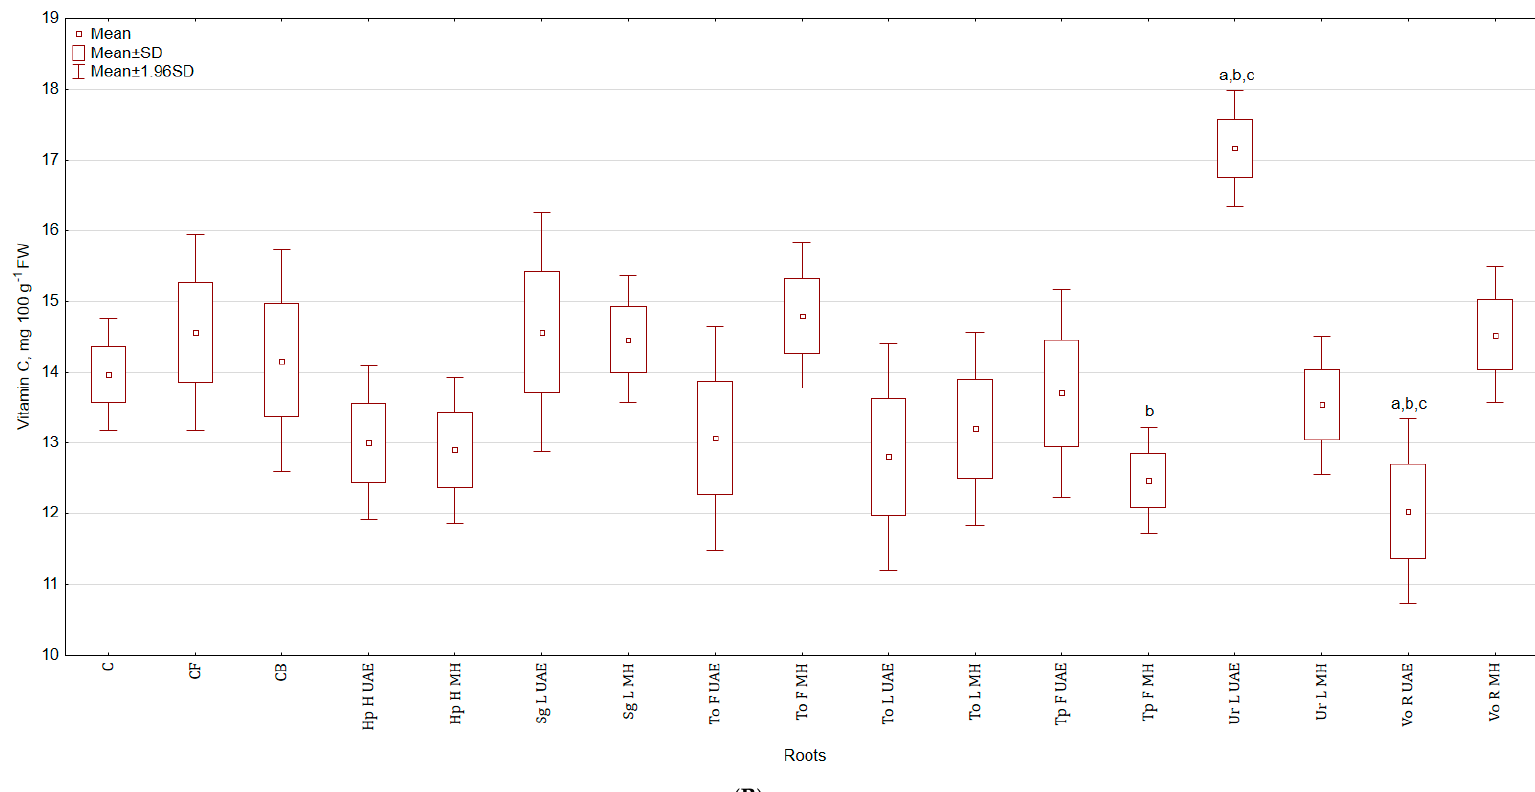
Figure 3. ( A ) Effect of the foliar application of botanical extracts on the vitamin C content of celeriac leaves (N = 4). ( B ) Effect of the foliar application of botanical extracts on the vitamin C content of celeriac roots (N = 4). (a) Statistically significant differences ( p < 0.05) between the control group (C) and extracts. (b) Statistically significant differences ( p < 0.05) between water formulation (CF) and extracts. (c) Statistically significant differences ( p < 0.05) between commercial biostimulant (CB) and extracts. 1st term of leaves rosette collection—samples taken for analyses 7 days after the second spraying. 2nd term of leaves rosette collection—samples taken for analyses after harvesting. Abbreviations: UAE, ultrasound assisted extraction; MH, mechanical homogenisation; Hp H, Hypericum perforatum L. (St. John’s wort, herb); Sg L, Solidago gigantea Ait. (giant goldenrod, leaf); To F, To L, Taraxacum officinale (L.) Weber ex F.H. Wigg (common dandelion, flower, leaf); Tp F, Trifolium pratense L. (red clover, flower); Ur L, Urtica dioica L. (nettle, leaf); Vo R, Valeriana officinalis L. (valerian, root).